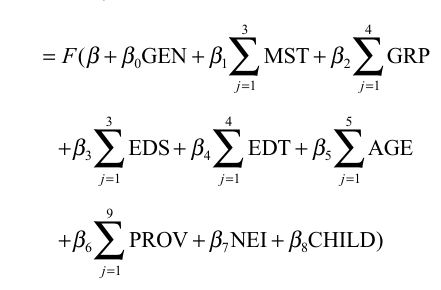
the gender dummy. From Table 2, a picture of the